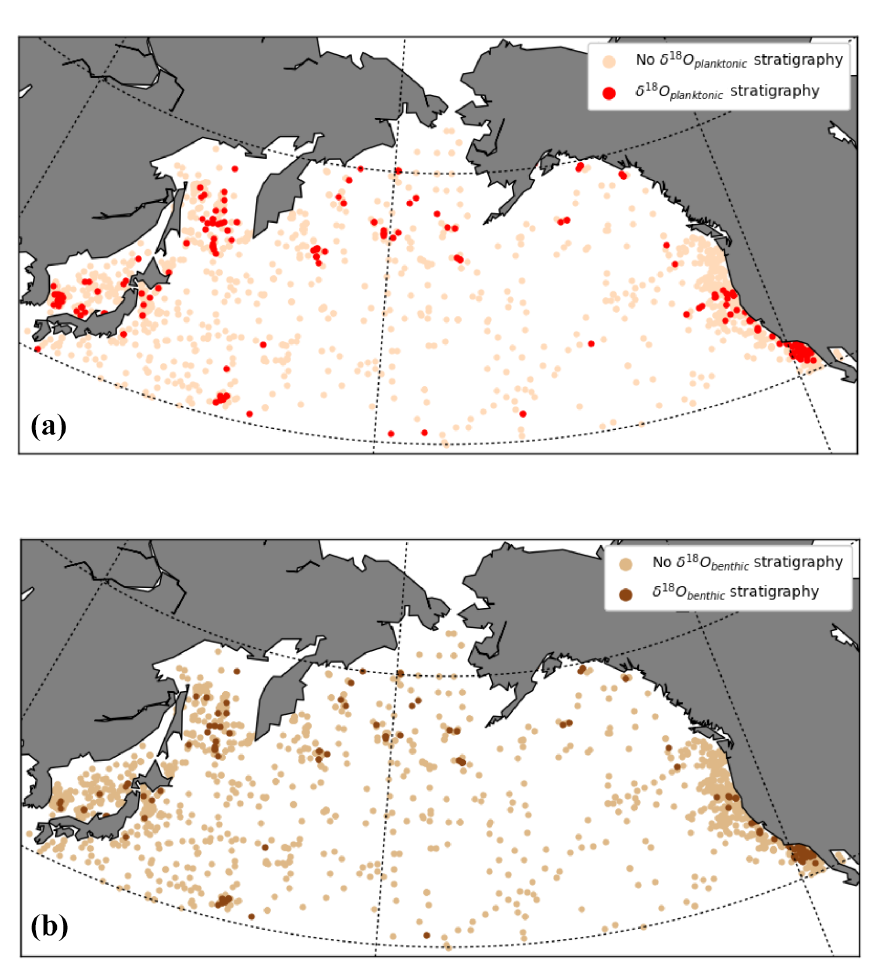
Figure 4. Published planktonic and benthic foraminiferal oxygen isotope stratigraphy for sediment core age models. (a) Analysis of plank- tonic foraminiferal oxygen isotopes and (b) analysis of benthic foraminiferal oxygen